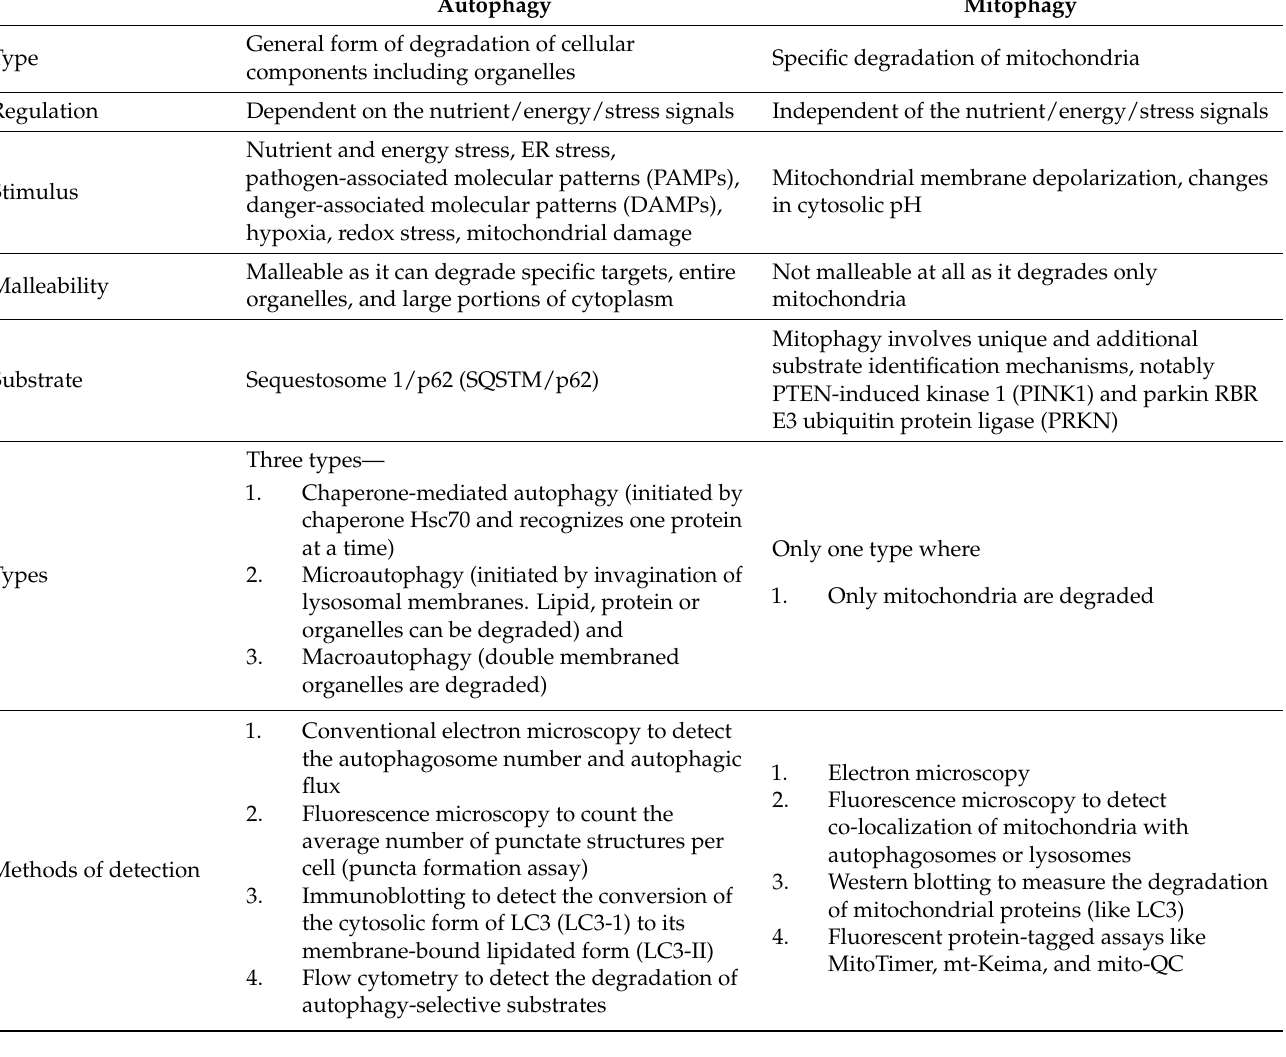
Table 1. Differences and similarities between autophagy and mitophagy. Autophagy